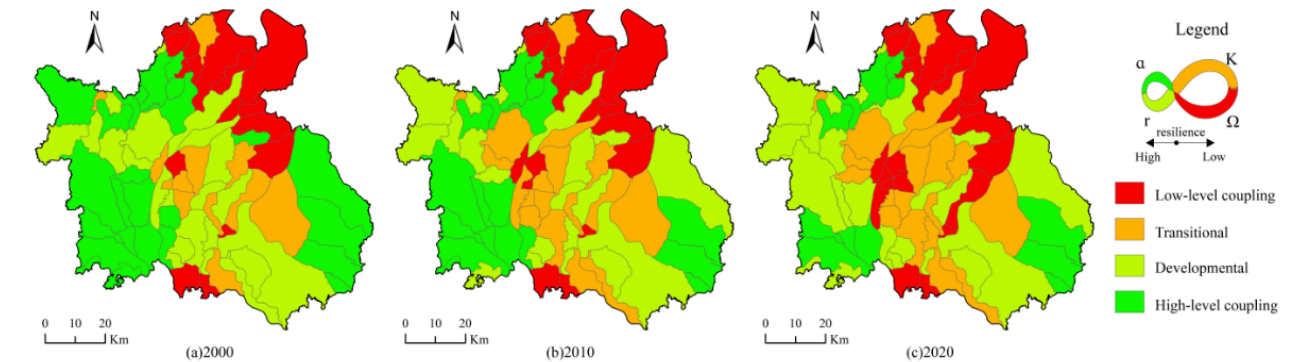
Figure 8. Adaptive cycle phase of urban resilience of each group based on coupling coordination degree.